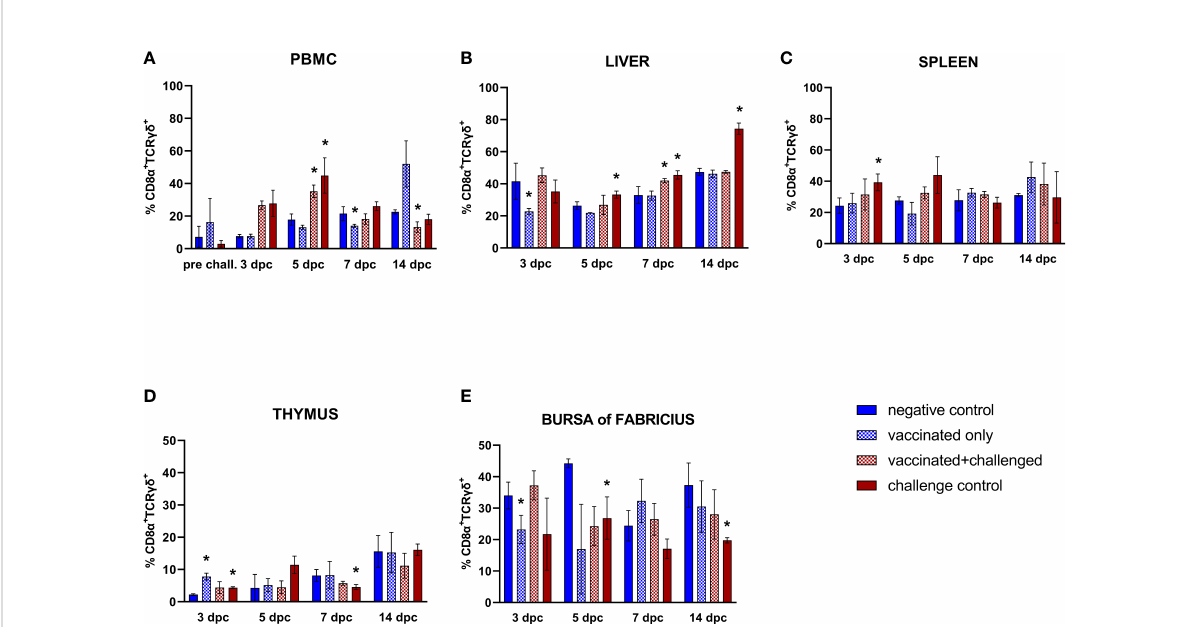
FIGURE 7 Relative number of CD8 a + TCR gd + T lymphocytes within total CD8 a + T lymphocytes measured via FCM for each experimental group throughout the study in PBMC (A) , liver (B) , spleen (C) , thymus (D) , and bursa of Fabricius (E) . Data for the two vaccinated groups (vaccinated only and vaccinated+challenged) are merged to determine values in PBMCs pre-challenge. Asterisks represent signi fi cant difference compared to the negative control at each time point ( p ≤